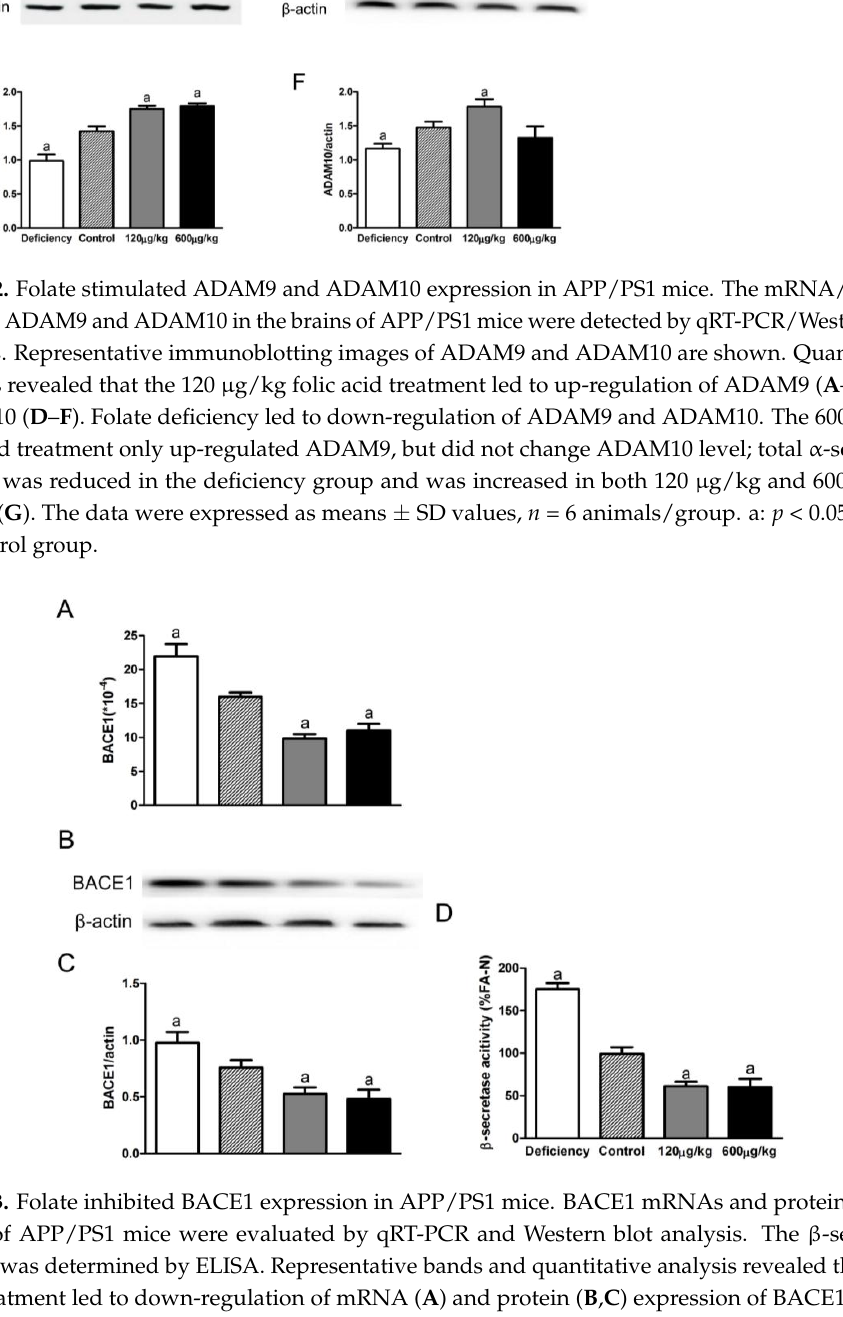
Figure 4. Folate inhibited PS1 expression, but not NCT (nicastrin), in APP/PS1 mice. PS1 mRNAs and proteins in the brains of APP/PS1 mice were determined by qRT-PCR and Western blot analysis. Folic acid treatment inhibited PS1 mRNA and protein expression. Folate deficiency led to up-regulation of PS1. No difference in PS1 expression was showed between 120 μg/kg and 600 μg/kg groups ( A – C ); However, Western blot analysis revealed that folic acid did not change NCT protein levels ( D , E ). The data were expressed as means ± SD values, n = 6 animals/group. a: p < 0.05 versus the Control group.